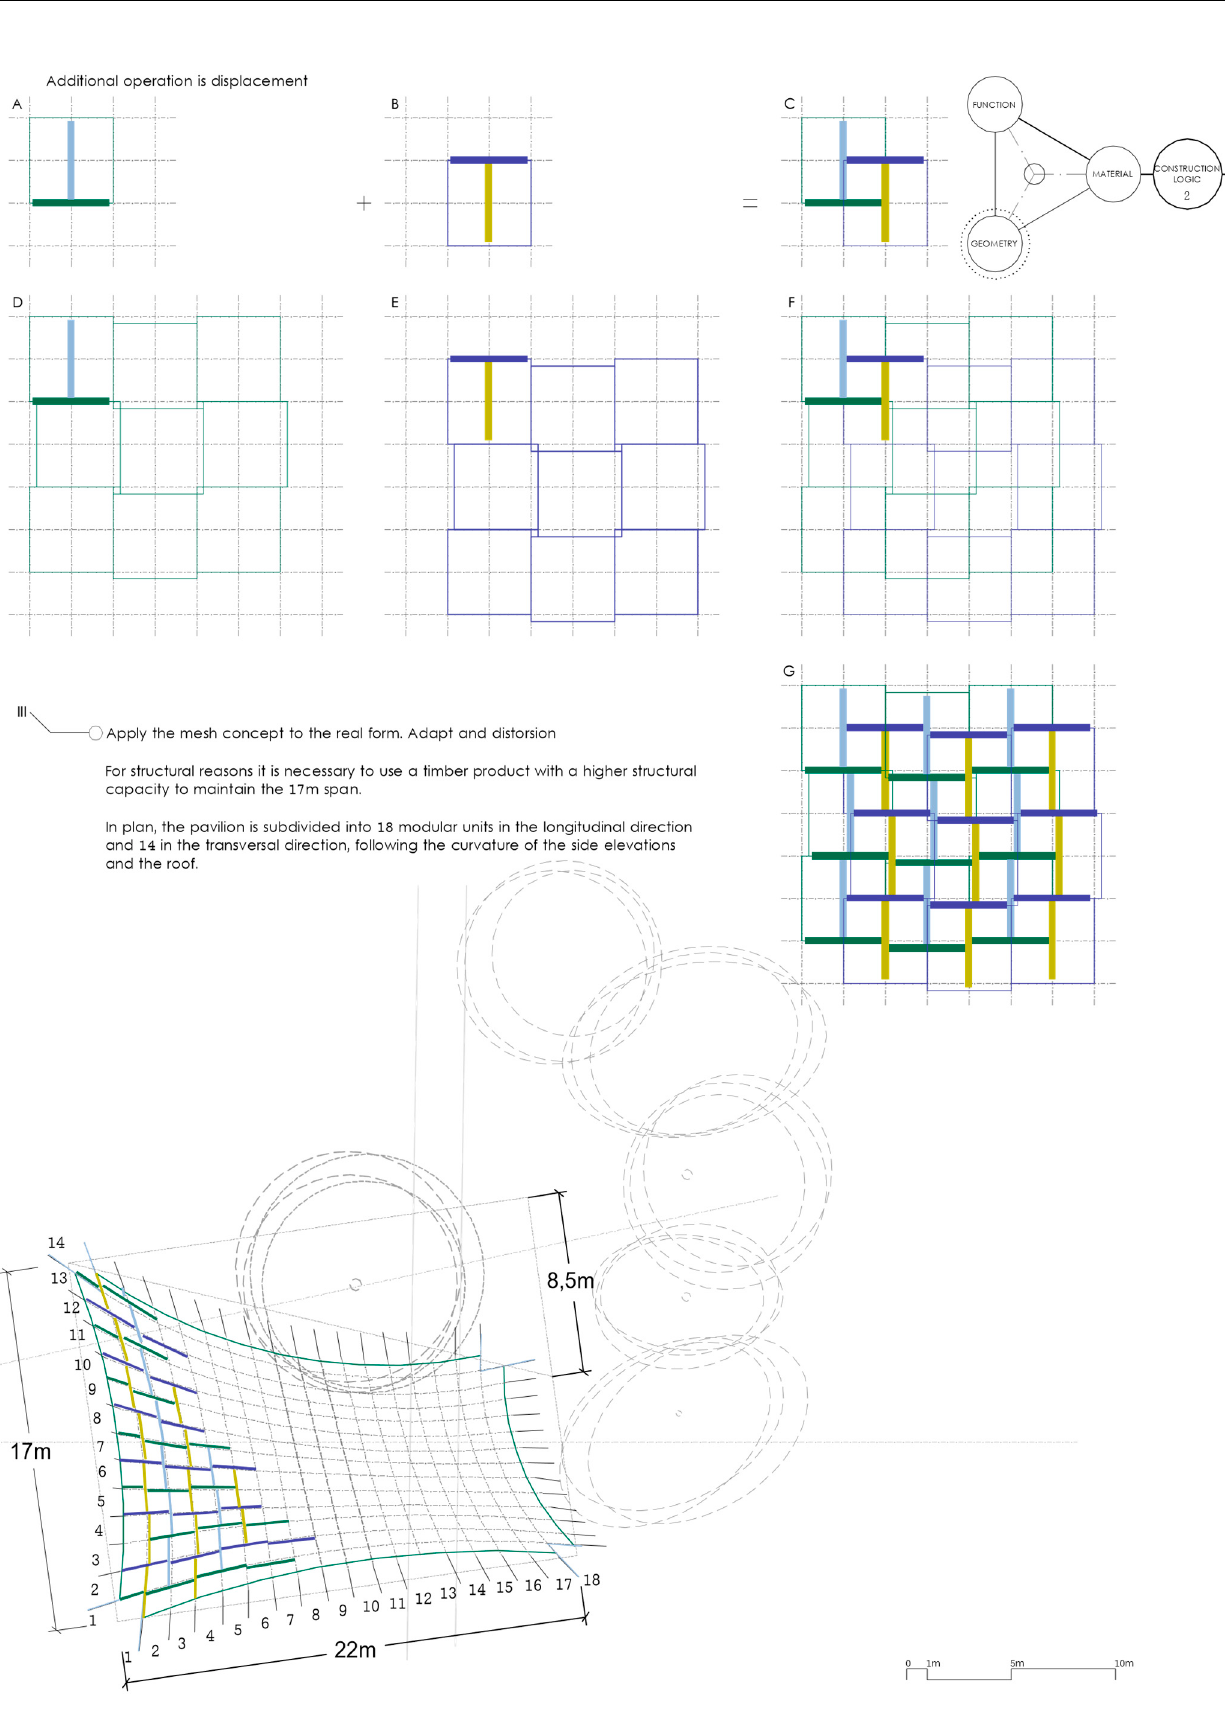
Figure 13. Construction logic matrix 2.